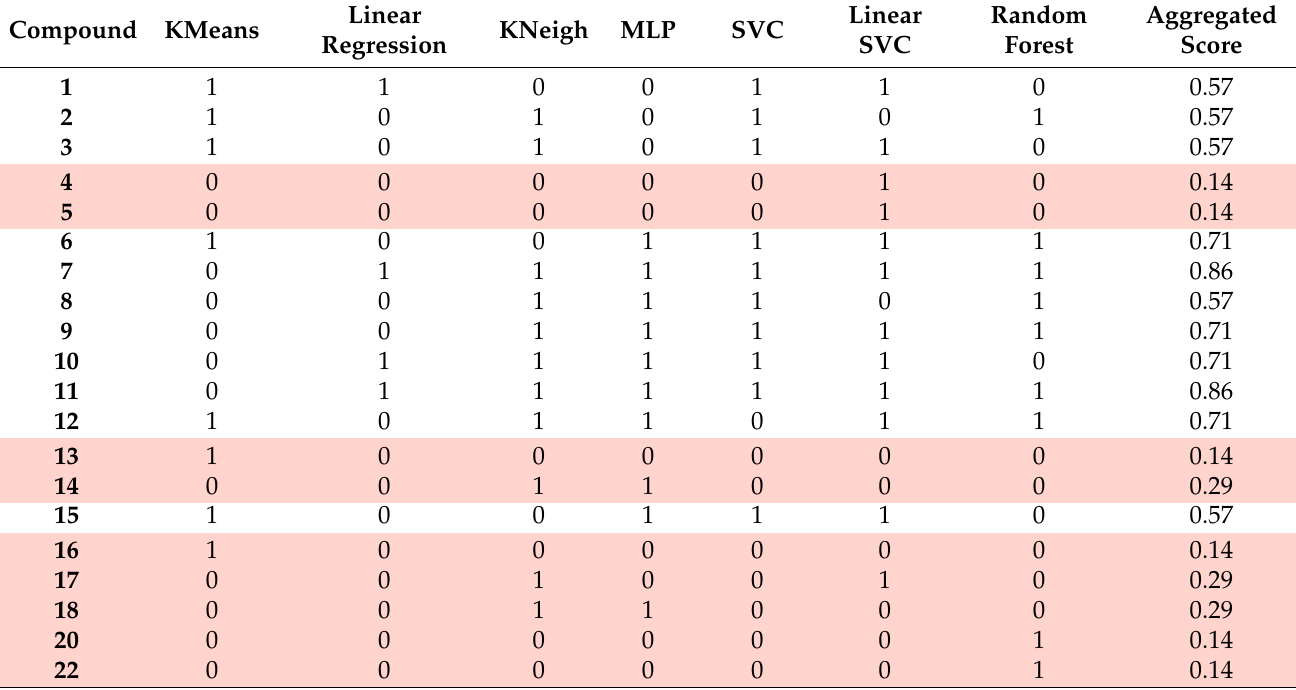
Table 1. The predicted label for each of tested compound (i.e., 0 means lack of anti-TB activity, and 1 means anti-TB activity), using K-Means, Linear Regression, K-Nearest Neighbors, Random Forest, SVC, Linear SVC, and MLP machine learning algorithms. The last column presents the average label value, representing the aggregated score. Compounds with a 0.5 lower aggregated score are highlighted in red.